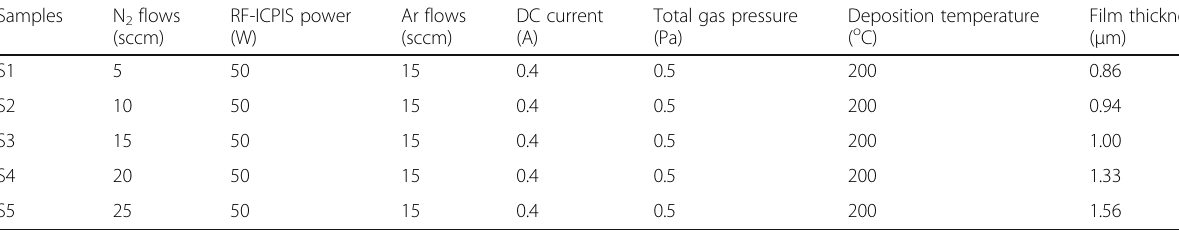
Table 1 Growth parameters of Ti-Al-N films during deposition progress